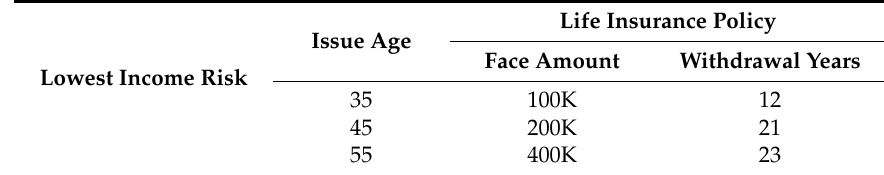
Table 5. Insurance parameters that yield the lowest income risk.